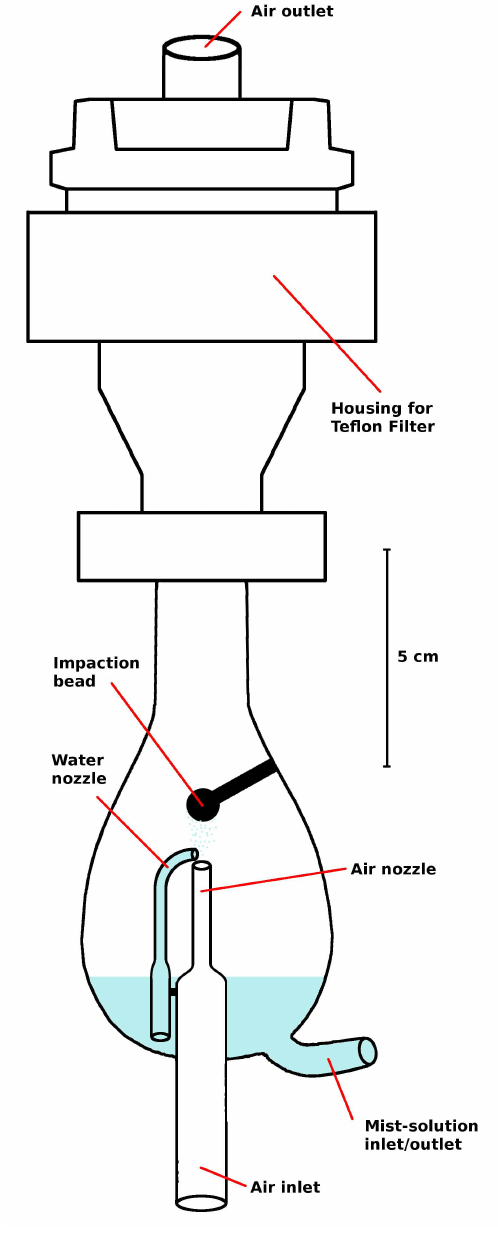
Figure 4. Schematic of a mist chamber (to scale). The teflon filter (only housing is shown) serves as a liquid barrier.